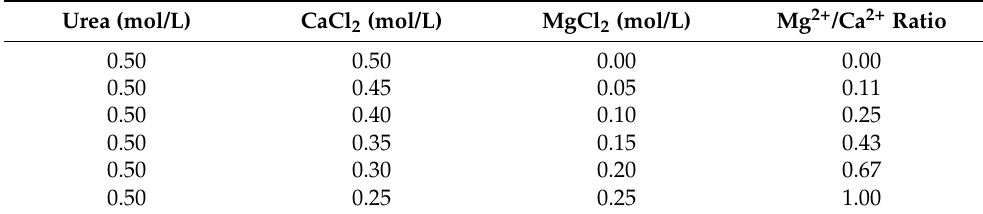
Table 1. Testing conditions for the CaCO 3 precipitation test.